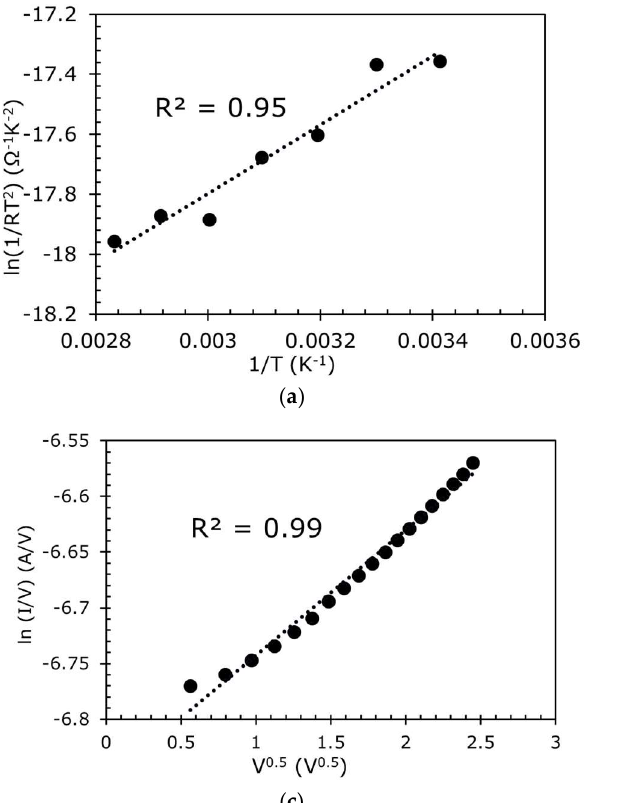
( b ) Figure 8. ( a ) Instron machine 5866 used to conduct the compression stress, and the obtained ( b ) compression stress and versus compression strain plot. As the composite film is compressed vertically, there is some orthogonal (horizontal) strain, and this causes the barrier height in the Cu-Ecoflex 00-30 ( qΦ B ) to increase [47], which increases the resistance of the sensor as the electrons require higher energy to over- come the barrier height. It is believed that this causes the change in resistance in Region I of Figure 4b. Further from Figure 8b, the compression strain increases more rapidly when the pressure increases from 0 to 10 kPa (strain change from 0% to 31% with a pressure change of 10 kPa), which leads to the corresponding orthogonal strain and increases the resistance with pressure in Region I.